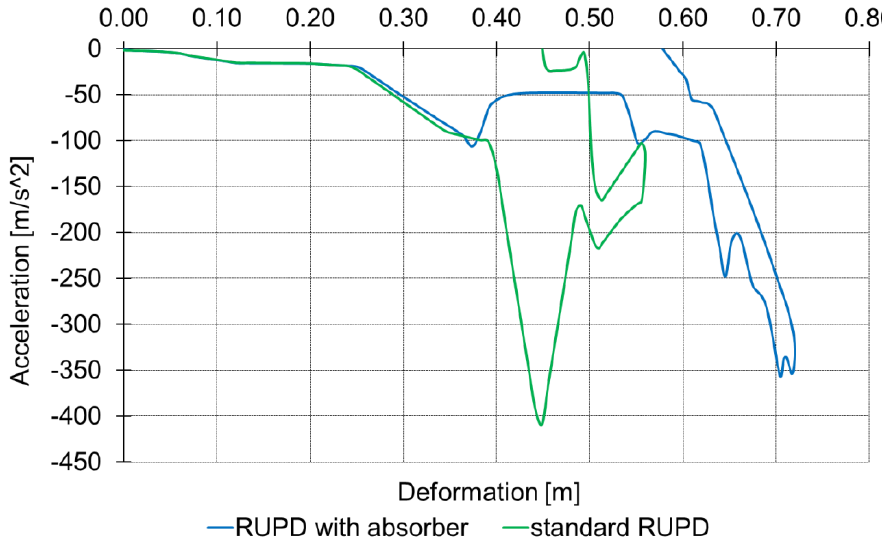
Figure 24. Results of computer simulation tests on the rear-end impact of a passenger car against a motor truck provided with a standard RUPD and an RUPD with an energy